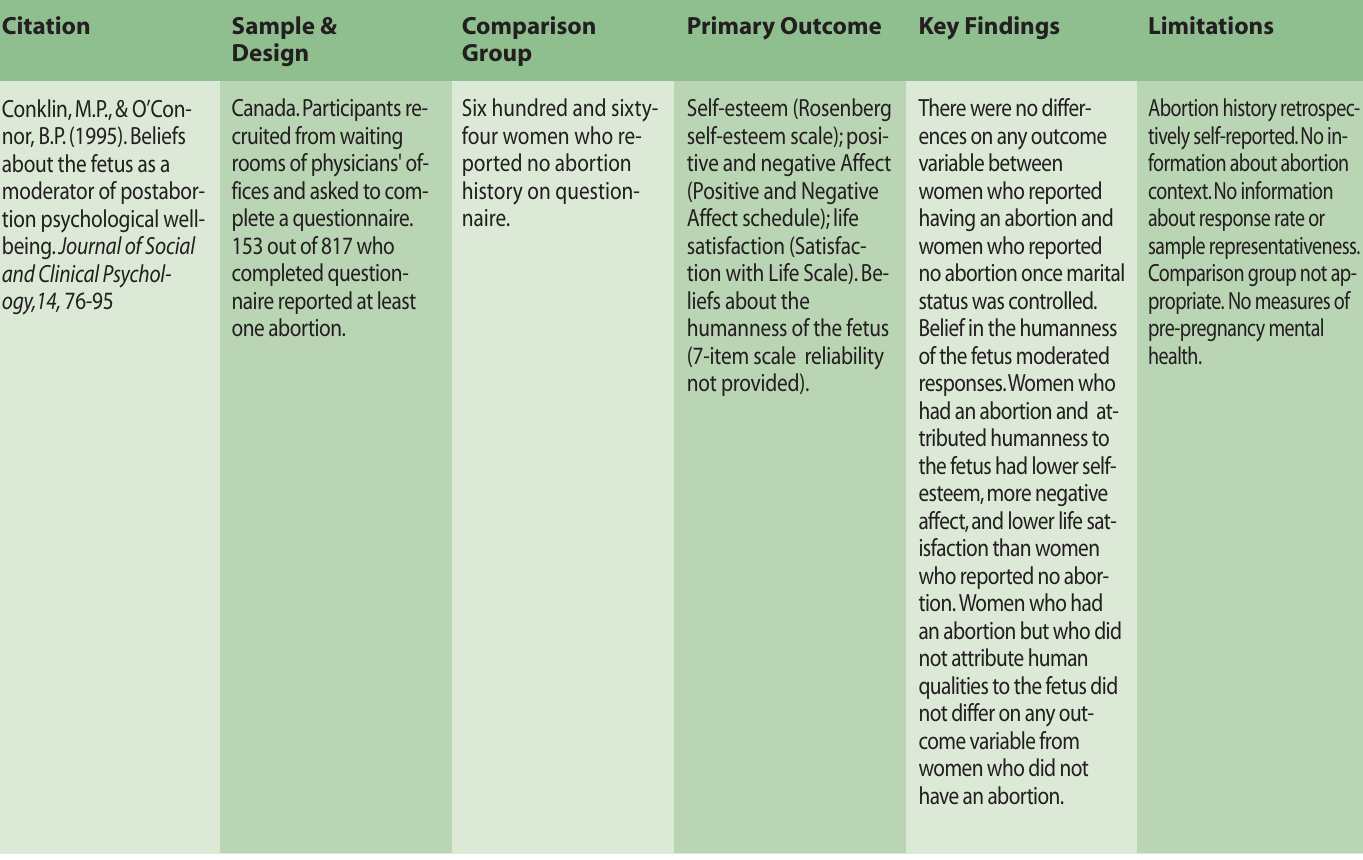
Table 3B: Comparison Group Studies